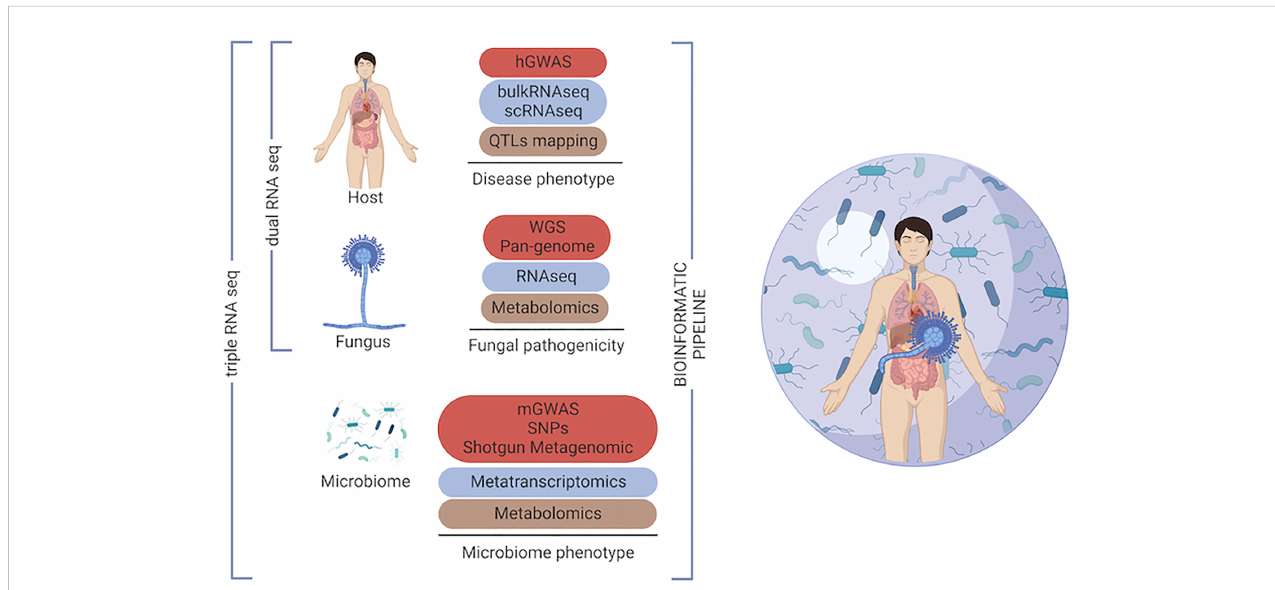
FIGURE 2 Omics toolkit for investigating the ‘ genetic triangle ’ in the human host during fungal infection. Multi-omics approaches, which enable intermediate phenotypes into the host, the fungus and the host microbiome to be measured by different -omics technologies. Genome-wide association studies (GWAS), quantitative trait locus (QTLs), single nucleotide polymorphism